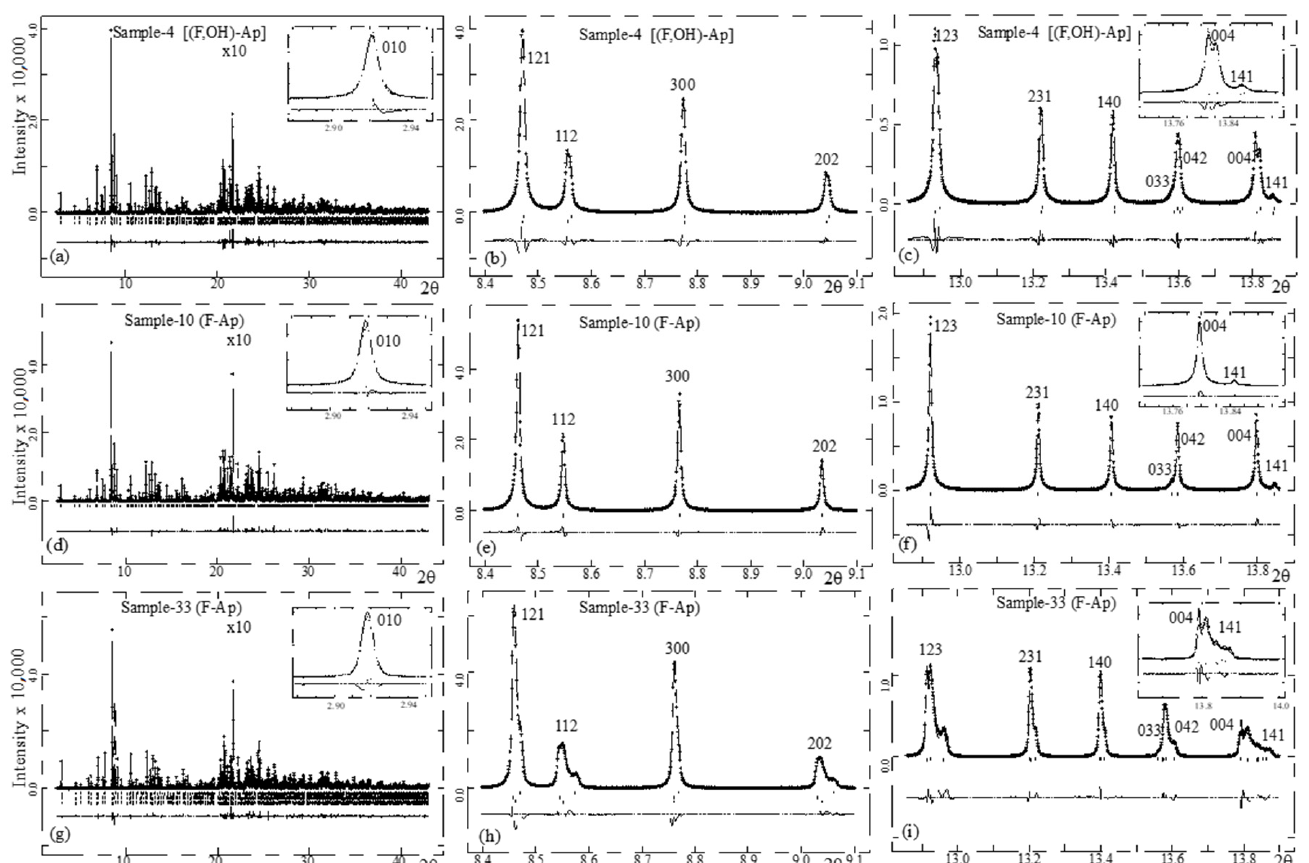
Figure 6. HRPXRD traces at 20 ◦ C together with the calculated (continuous line) and observed (crosses) profiles for three different Ap samples. The difference curve Figure6 ( I obs − I calc ) with the same intensity scale is shown at the bottom of the trace. Short vertical lines indicate allowed reflection positions. The intensities for the trace and difference curve that are above 20 ◦ 2 θ are multiplied by 10 in ( a , d , g ), which also contain inserts of the 010 reflection; ( a – c ) are a two-phase intergrowth of F-Ap and OH-Ap in sample-4; ( d – f ) are a single-phase F-Ap sample-10; ( g – i ) are a three-phase intergrowth of three slightly different F-Ap (68.1, 14.5, and 17.4 wt.%) in sample-33 from Sapo, Brazil. The expanded scales ( b , c ) show that sample-4 is a two-phase intergrowth of F-Ap (44 wt.%) and OH-Ap (56 wt.%), which gives rise to split reflections instead of un-split reflections, as in the single-phase sample-10 ( e , f ). The split peaks are easily observed for the 004 reflection in ( c , i ), as well as other reflections such as 123 and 202 in ( h , i ). In ( i ), locations for 004 and 141 reflections are for phases-33a and -33b, but these peaks are reversed in